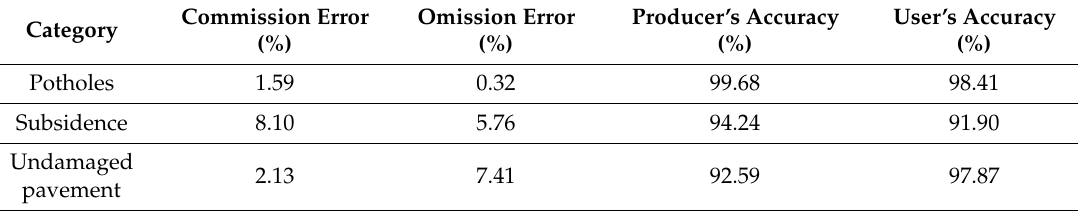
Figure 18. Pavement distress classification results of the validation data.